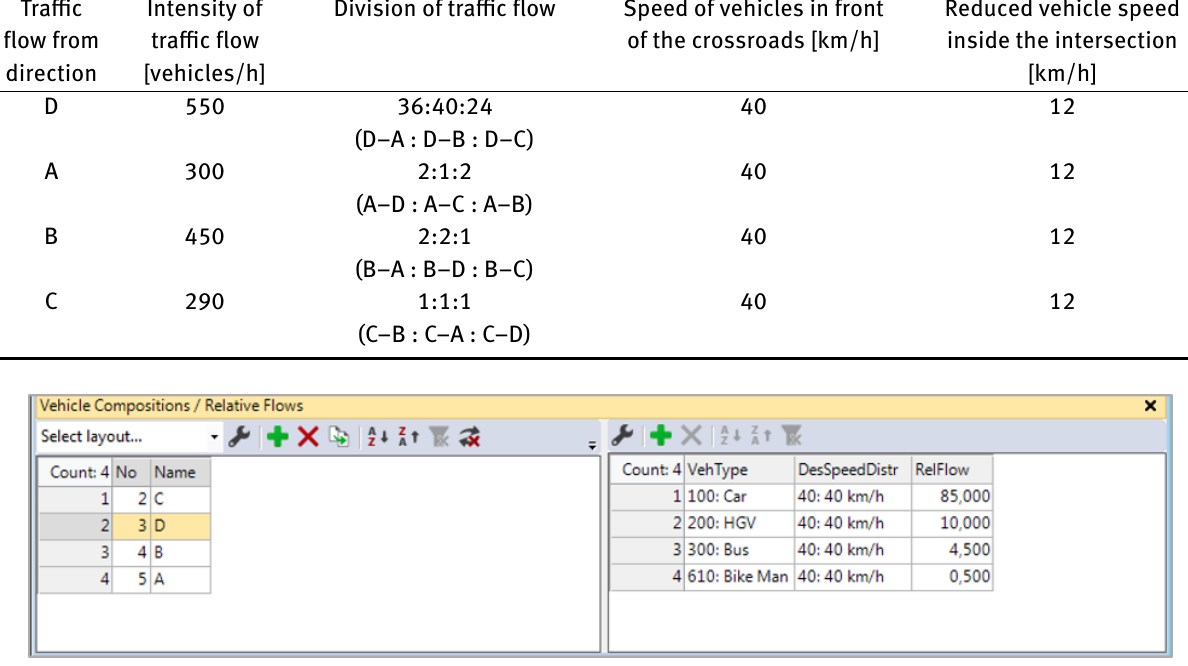
Figure 5: Traflc composition from D direction entered in the simulation